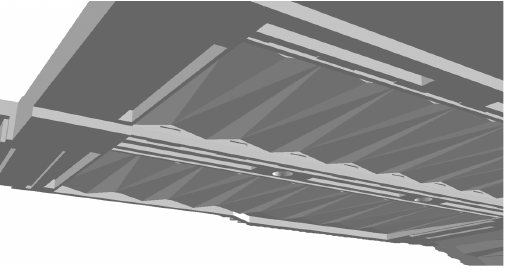
Figure 4. Ticket hall ceiling - intended geometry